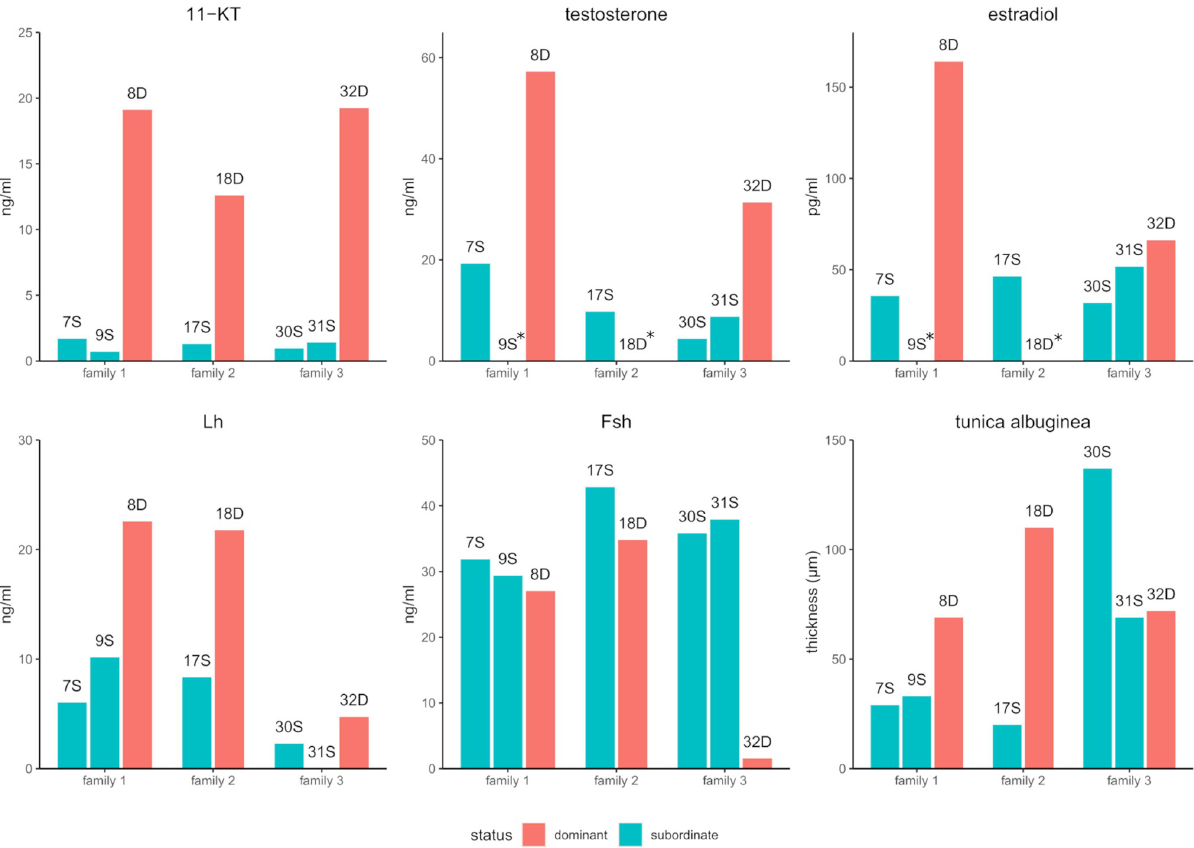
Fig 2. Plasma hormone values and TA diameter. Plasma values of 11-KT, T, E2, Lh and Fsh for each of the experimental animals. Data is represented as obtained by ELISA. Diameter of the TA is also provided for each animal as measured under the confocal microscope. Asteriks ( � ) marks samples for which hormone measurement was not possible due to limited plasma